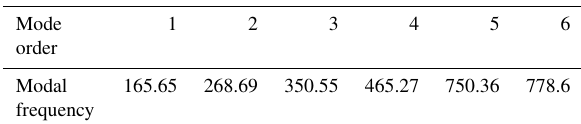
Table 5. The sixth-order modal frequencies of the clamping arm